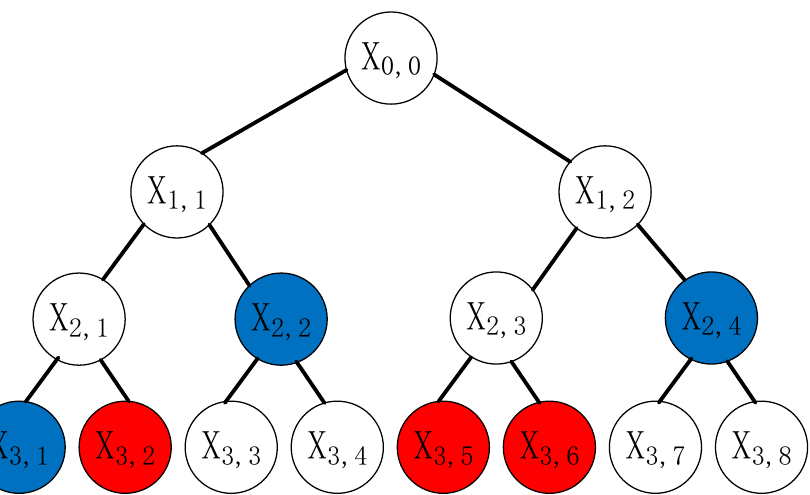
Figure 5. Example of SCST generation process. (The nodes to be revoked are represented in red, and the new subset covering the node is represented in